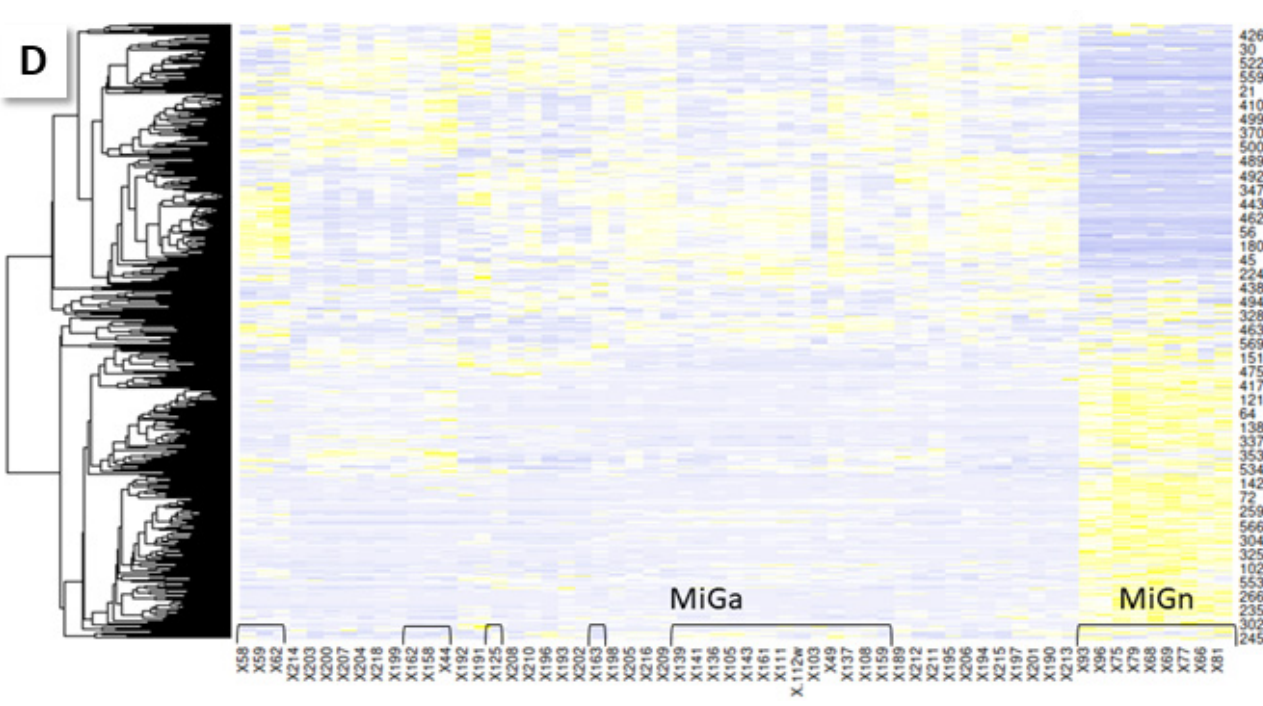
Figure 4. Heatmaps of serum sample results (Spearman rank). A clear distinction in the protein profiles between gastritis samples ( B ) and all other groups ( A ) is detected. Most interestingly, a part of the MiG cases (called MiGa below) cluster with GC samples. ( C ) Zoom-in. ( D ) Heatmap of MiG and GC samples clustered by rows and columns. Brackets indicate MiG samples; all other samples are from GC patients. Regular MiG (MiGn) is set apart from GC/MiGa. Table 2. 25preGC-panel: proteins upregulated in MiGa vs. NGM, and not shared with MiGn vs. for validation as serum markers and their detection results. Sorted by decreasing